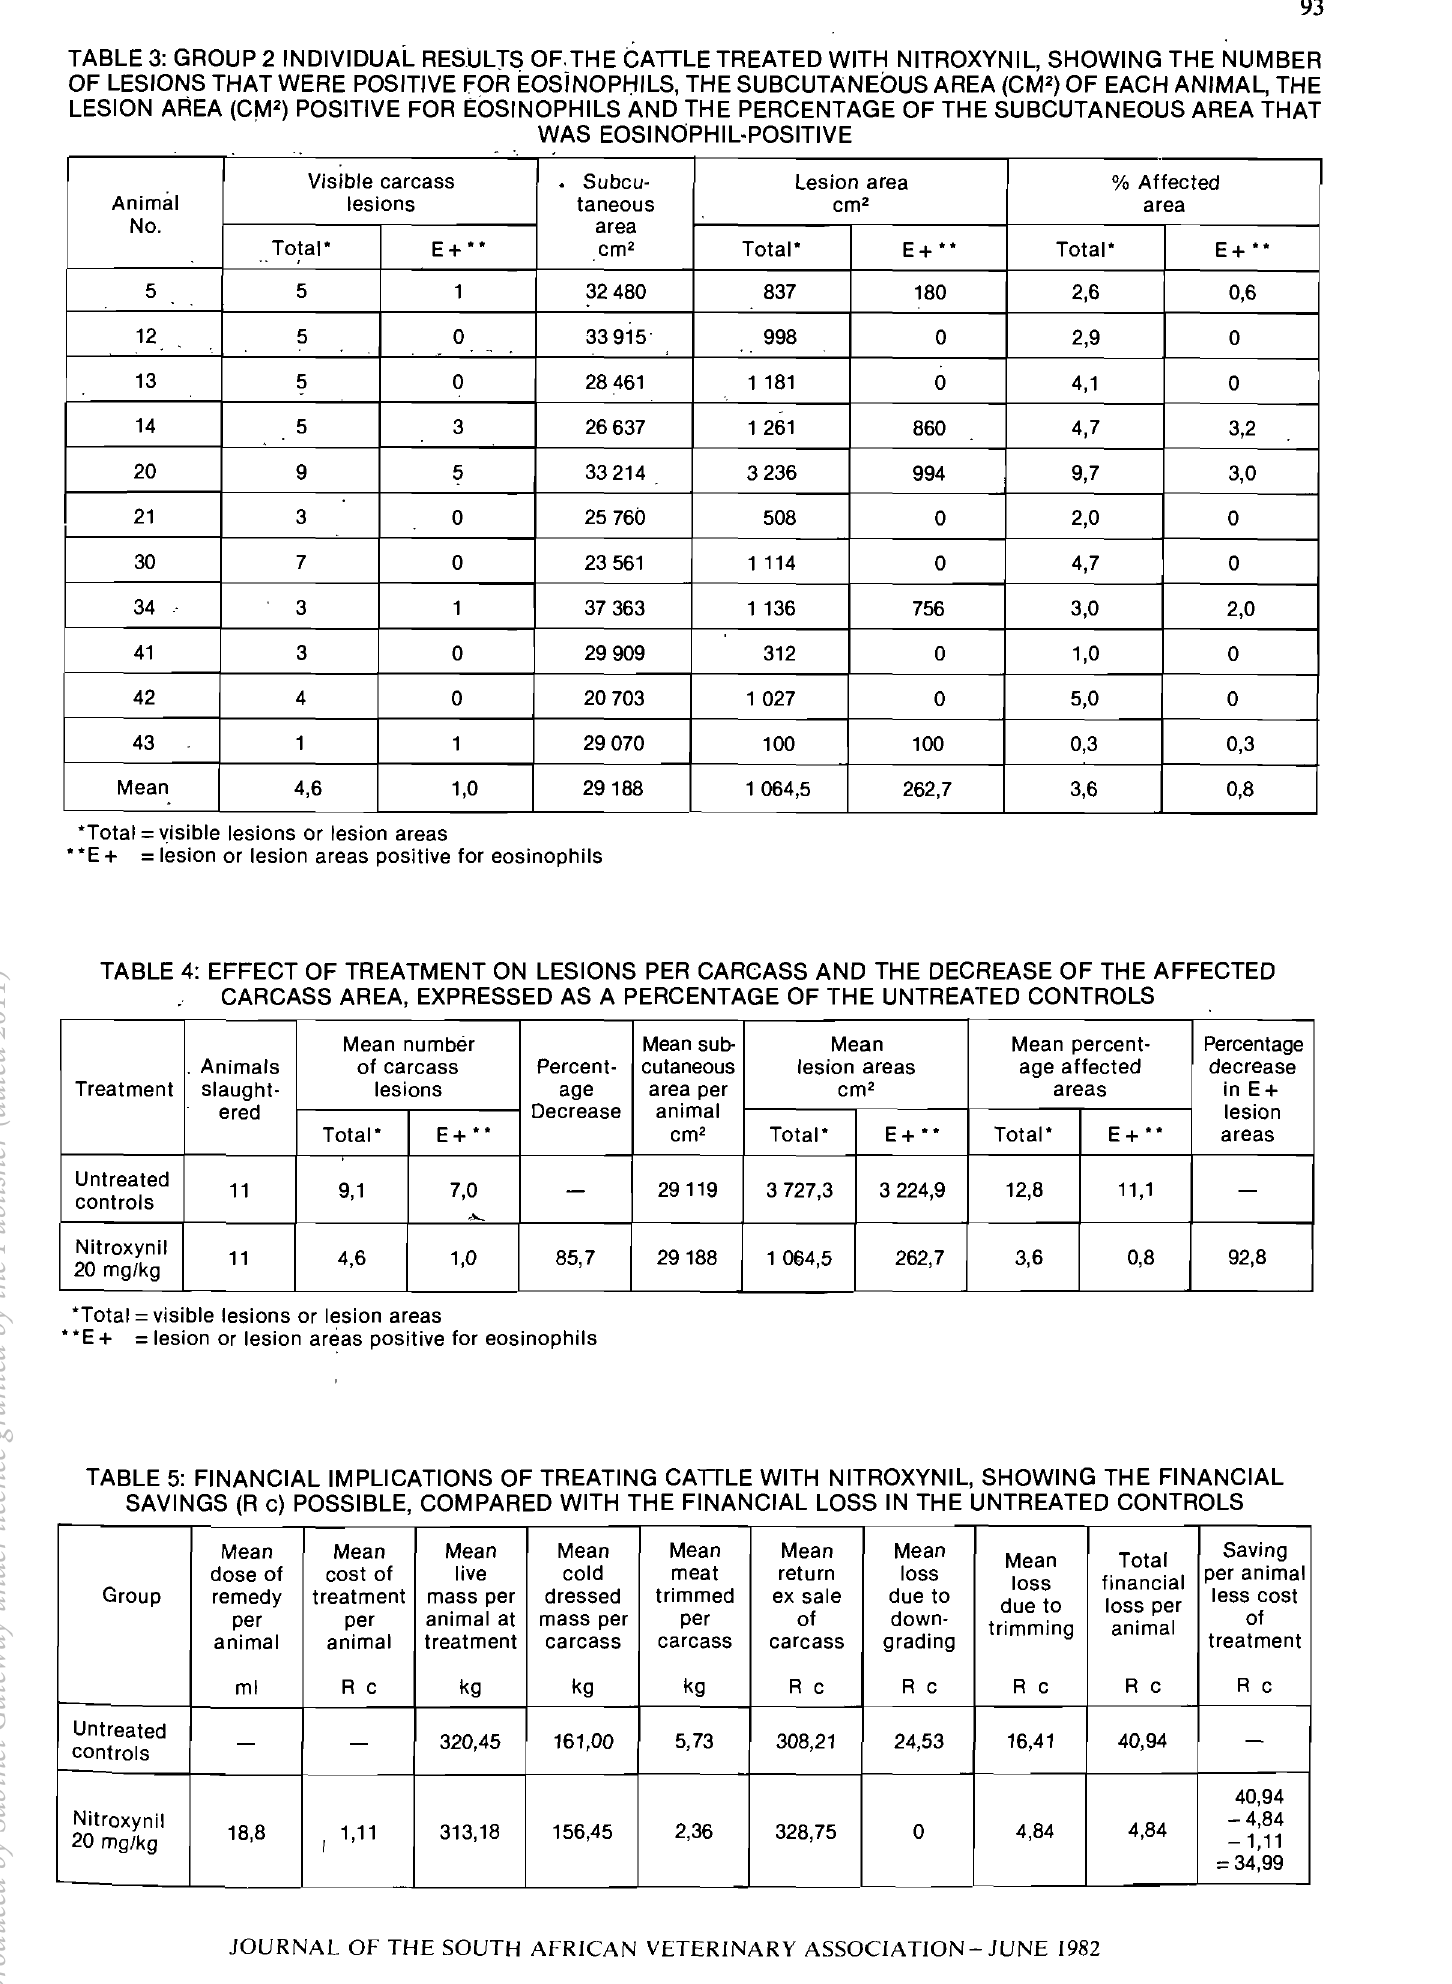
TABLE 5: FINANCIAL IMPLICATIONS OF TREATING CATTLE WITH NITROXYNIL, SHOWING THE FINANCIAL SAVINGS (R c) POSSIBLE, COMPARED WITH THE FINANCIAL LOSS IN THE UNTREATED CONTROLS